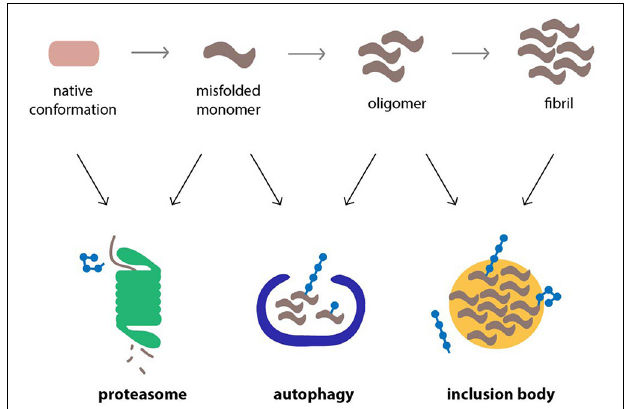
FIGURE 2 | Cellular pathways that counteract protein aggregation are ubiquitin-dependent processes. Proteins linked to neurodegenerative diseases, such as α -synuclein, β -amyloid peptide and polyQ proteins, are prone to misfolding and aggregation in the cellular environment. The proteasome, autophagy, and inclusion bodies form a network of quality control systems which reduces levels of misfolded proteins and counteracts aggregation. All three pathways are regulated by